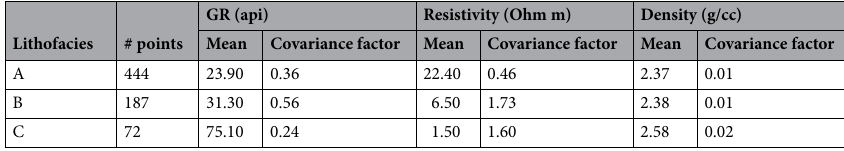
Table 1. Results of rock classification, clustering lithofacies into three